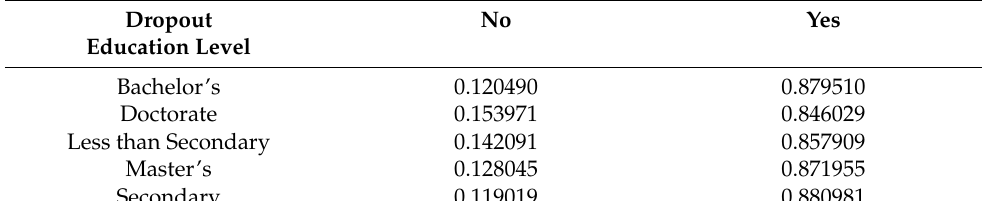
Table 6. Dropout rate among students with different academic qualifications